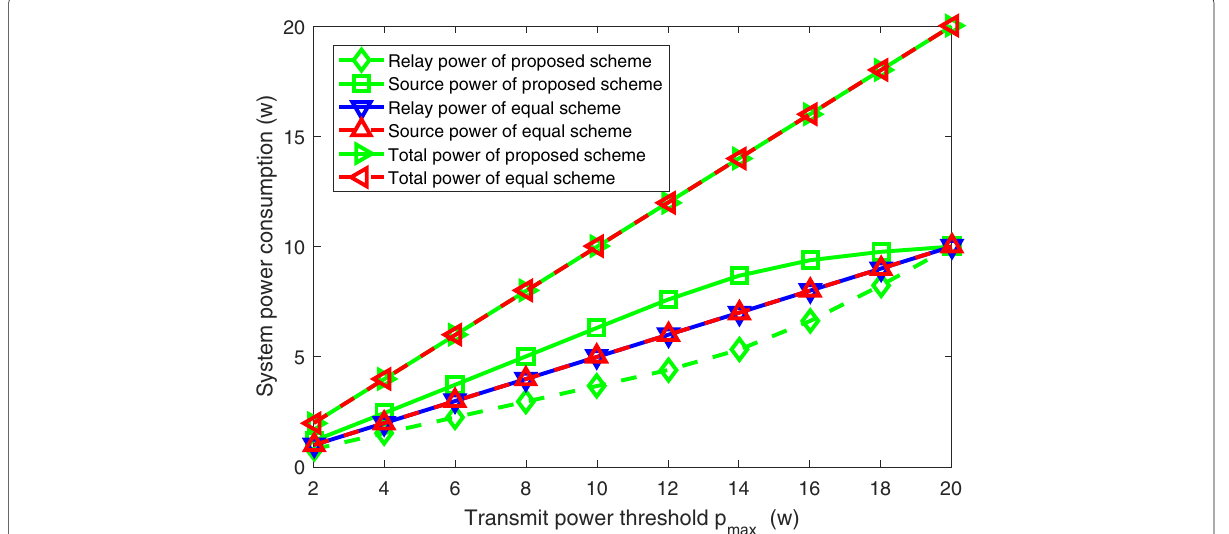
Fig. 3 Power consumption with the increasing total transmit power